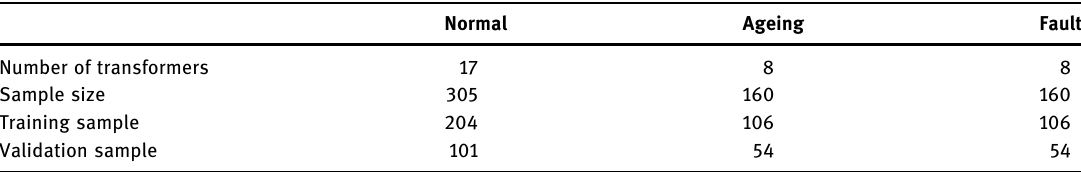
Table 1: Statistical table of sample